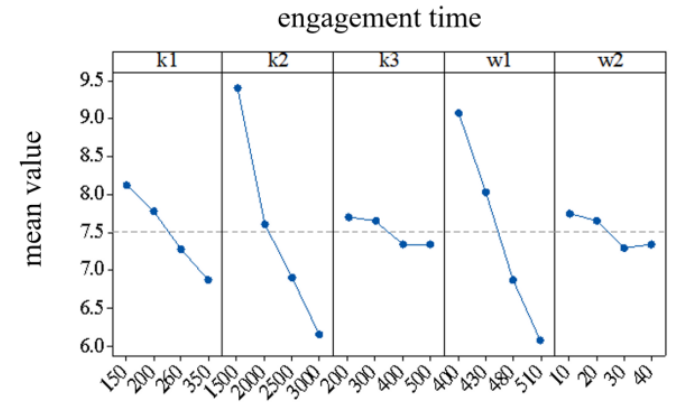
Figure 25. The influence of k2 on engagement time and impact Figure 25. The in fl uence of k2 on engagement time and impact torque.